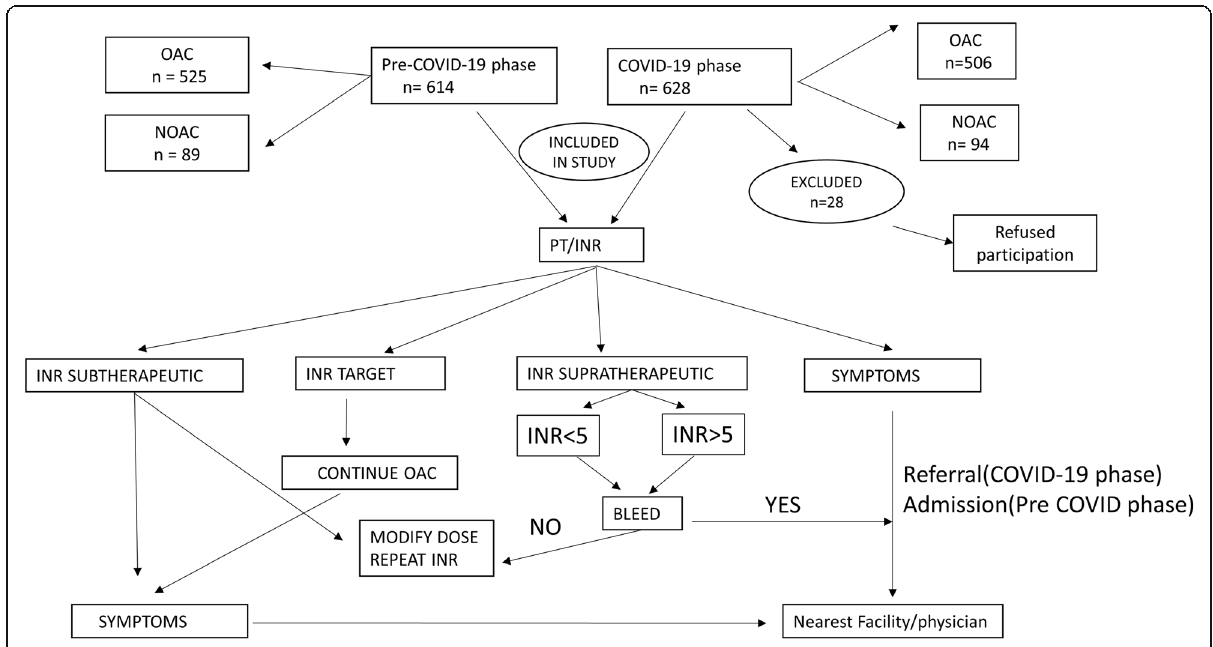
Fig. 1 Flow chart showing the methodology of the study (INR, international normalized ratio)